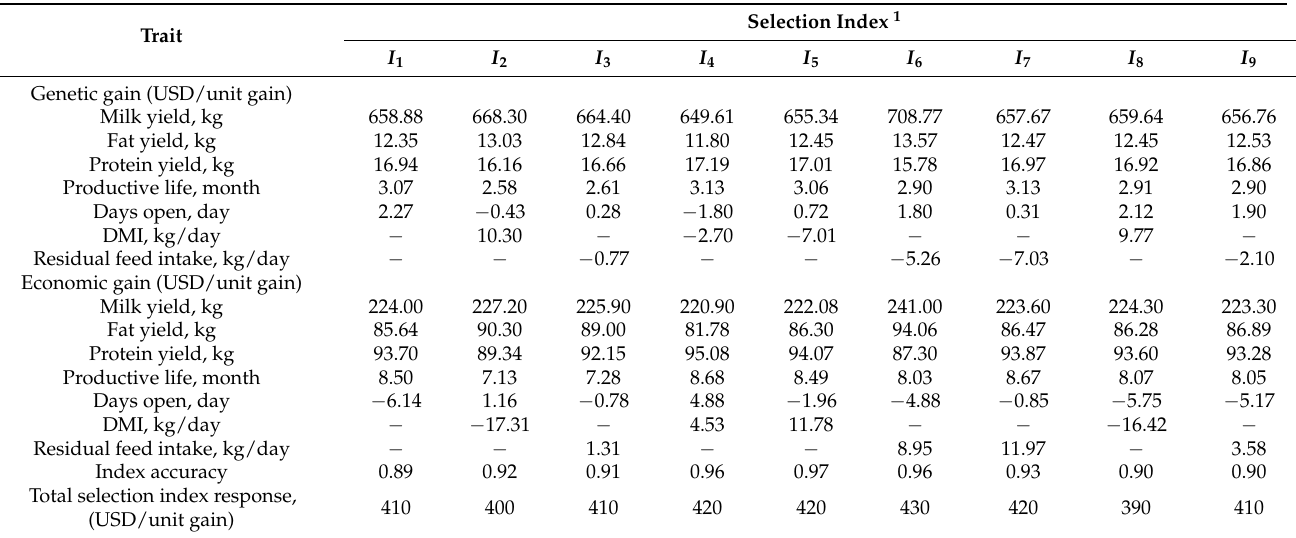
Table 6. Expected genetic and economic gains for breeding objective traits based on 9 selection indices, index accuracy, and total index